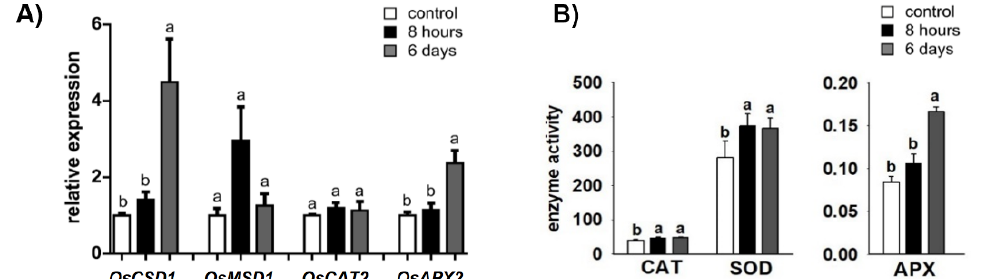
Figure 2. Relative expression levels of genes encoding antioxidant enzymes ( A ) and antioxidant enzyme activities (CAT—catalase, SOD—superoxide dismutase, and APX—ascorbate peroxidase) ( B ) in Q. suber roots under control and salinity conditions (8 h and 6 days after 300 mM NaCl treat- ment). The target genes were: copper/zinc superoxide dismutase ( QsCSD1 ), manganese superoxide dismutase ( QsMSD1 ), catalase ( QsCAT2 ), and ascorbate peroxidase 2 ( QsAPX2 ). White bars: control; black bars: 8 h; grey bars: 6 days. Values are mean ± SEM (n = 3–6). For each gene or enzyme different letters indicate significant differences between control and salinity treatments ( p < 0.05).